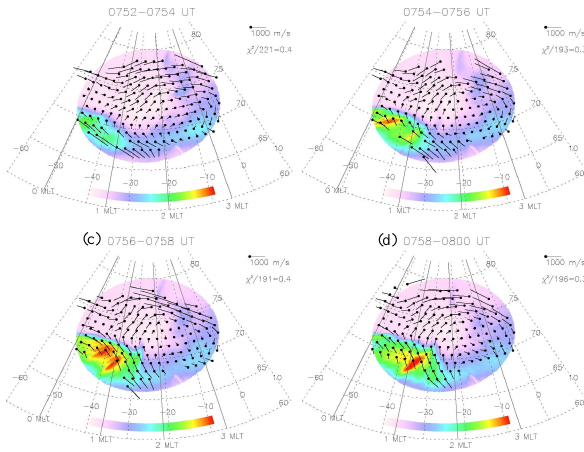
Figure 6 Maps similar to Figure 4, but for the period 0752-0800 UT. Fig. 6. Maps similar to Fig. 4, but for the period 07:52–08:00 UT.